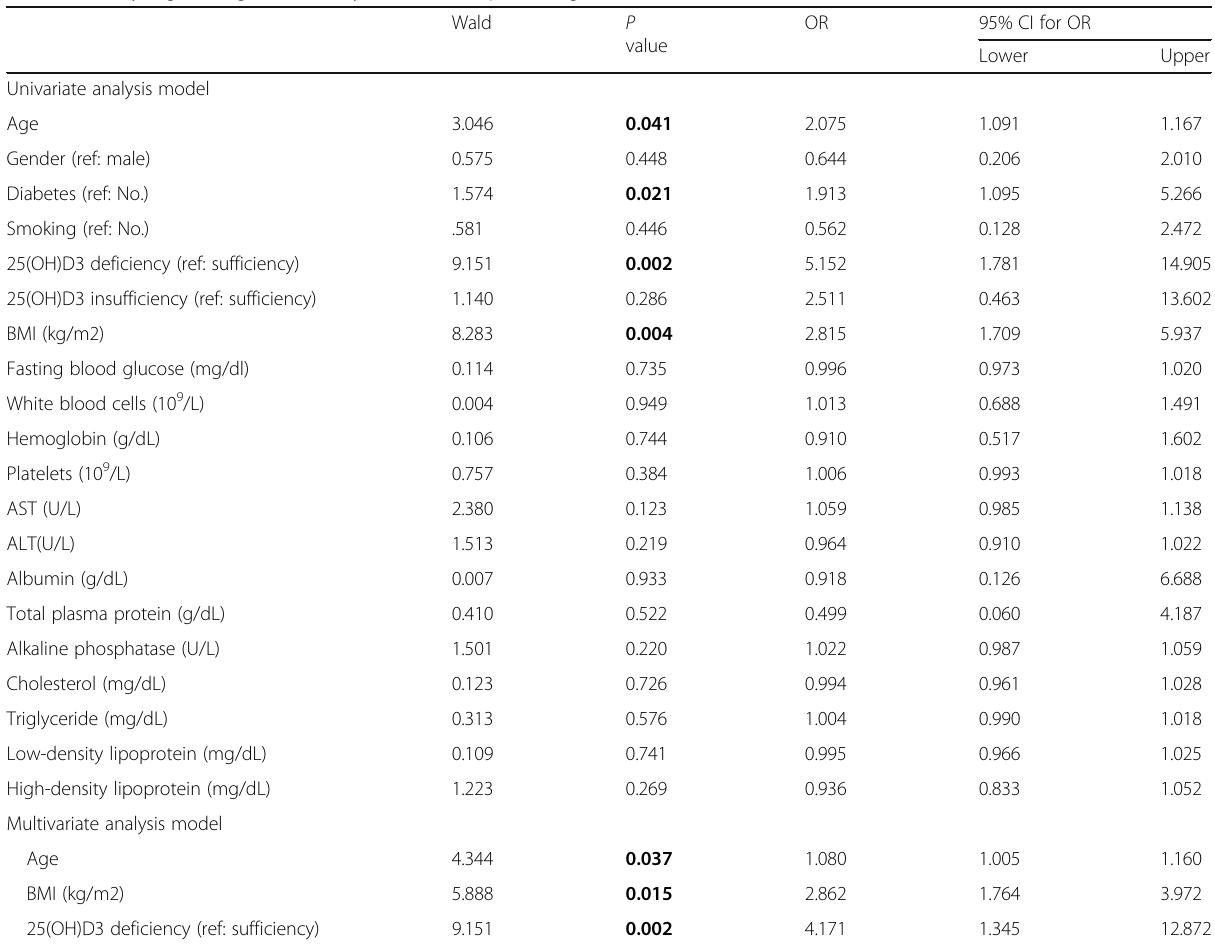
Wald P OR 95% CI for OR value Lower Upper